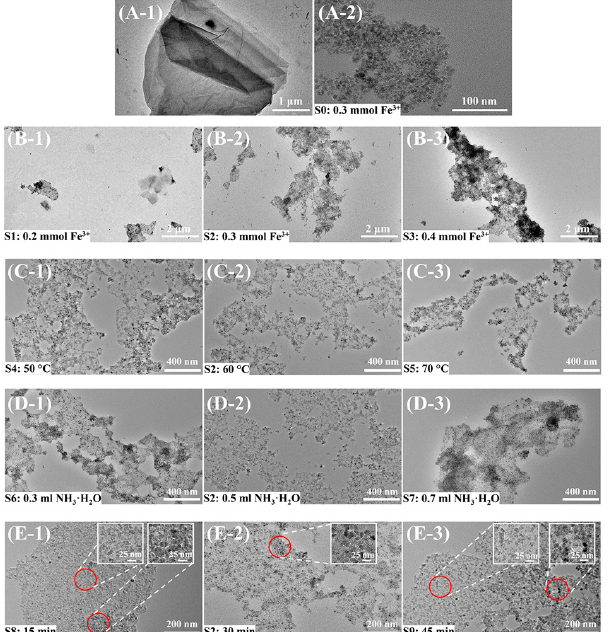
Figure 4. TEM images of GO, Fe 3 O 4 , and GO@Fe 3 O 4 prepared under various conditions. ( A-1 ) GO, ( A-2 ) Fe 3 O 4 ; ( B-1 – B-3 ) various ferric salt dosages; ( C-1 – C-3 ) various temperatures; ( D-1 – D-3 )